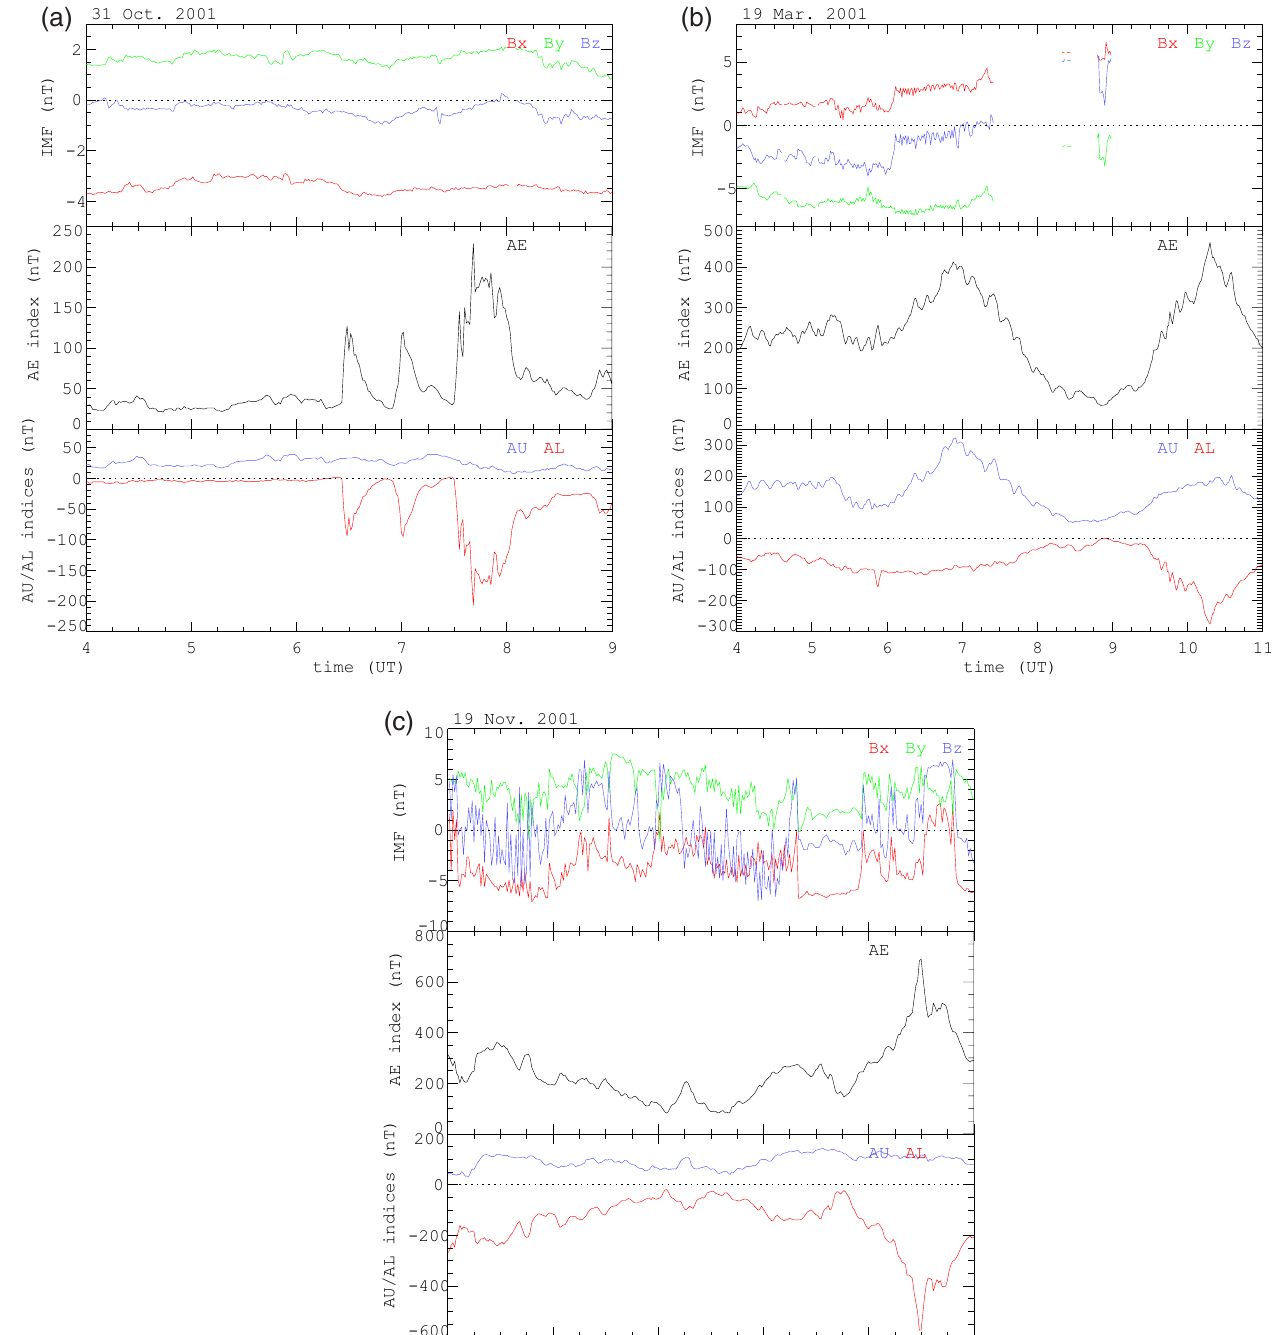
Figure 2. Interplanetary magnetic field (IMF) B x , B y and B z , and AL, AU and AE indices covering the time period of low-energy ion observations shown in Fig.